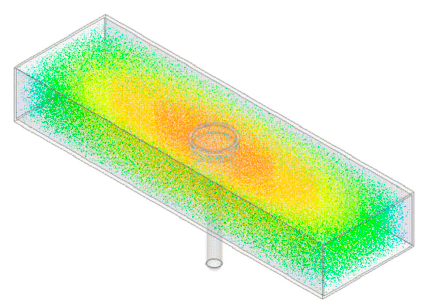
Figure 2. The resonant cavity model with electric field distribution overlay when resonant at approx. 1.5 GHz, which is where the TE 010 mode is present within the cavity according to Equation (1). Notably the electric field is concentrated, as noted by the red/orange coloration, around the EZ-Driploss container which ensures maximum interaction of the EM signal with the target sample.